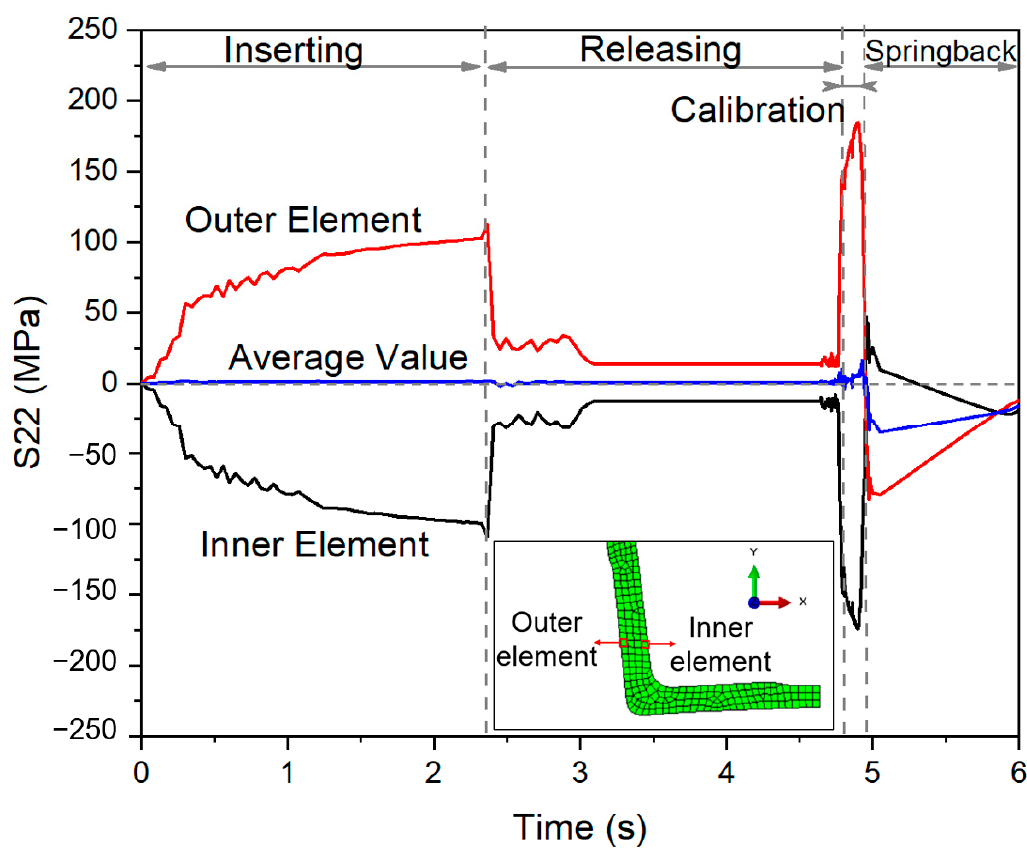
Figure 10. S22 evolution of two elements on the profile sidewall during the whole TSLB